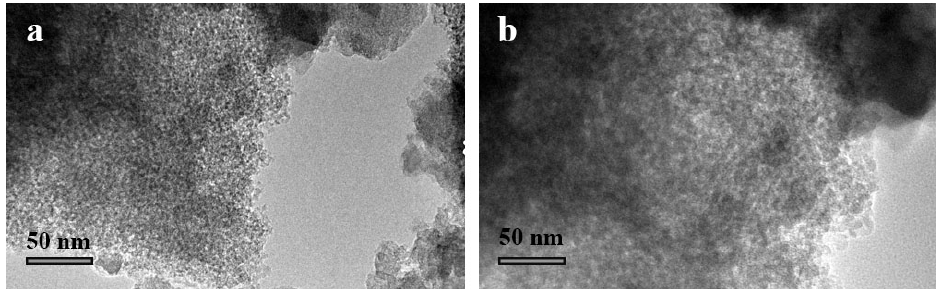
Figure 1. HRTEM images of Cefalexin@MSNs ( a ) and MSNs ( b ). The FTIR spectra of MSNs, cefalexin, and Cefalexin@MSNs are shown in Figure 2. The cefalexin has four obvious infrared absorption peaks at around 2925 cm − 1 ,1754 cm − 1 , 1688 cm − 1 , and 1576 cm − 1 , which are ascribed to the acidic hydroxyl group in the molecule, four-membered lactam carbonyl, secondary amide carbonyl groups, and N-H bending vibrations, respectively. The peaks at 797 cm − 1 and 1100 cm − 1 are assigned to the typical Si-O-Si stretching and bending vibrations [30,31], which are obvious in the MSNs and the Cefalexin@MSNs. Interestingly, the characteristic peaks of cefalexin at around 2925 cm − 1 and 1687 cm − 1 are strong in the Cefalexin@MSNs but are absent in the MSNs, indicating the incorporation of cefalexin into the MSNs.